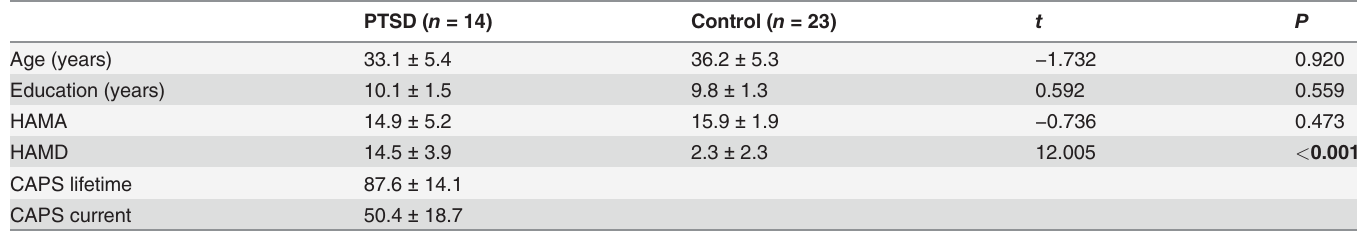
Table 2. Socio-demographic characteristics of subjects (Mean ±